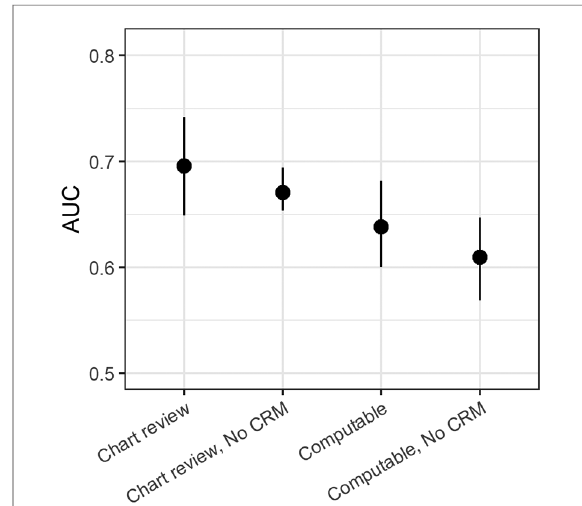
FIGURE 4 Area under the receiver operating characteristic (AUC) for predicting unplanned intubation based on chart review. For comparison, the AUC is also shown for combinations of models built to detect a computable phenotype and either using all features or excluding continuous monitoring data. Each AUC is based on 5-fold cross- validation with con fi dence intervals based on 200 bootstrap runs resampled by admission.